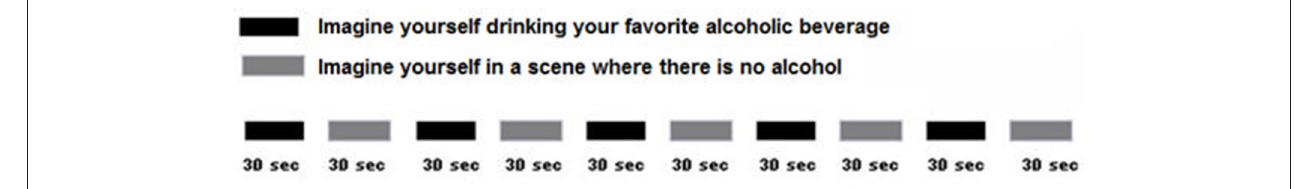
FIGURE 2 | During fMRI, patients self-generated images of themselves enjoying their favorite drink, and then self-generated images of themselves in a scene with no alcohol. This was designed to measure alcohol craving related brain activity. After pre-treatment craving ratings and their pre-treatment fMRI scans at the University of Washington, Seattle, patients returned to SSH where they participated in routine treatments for alcohol use